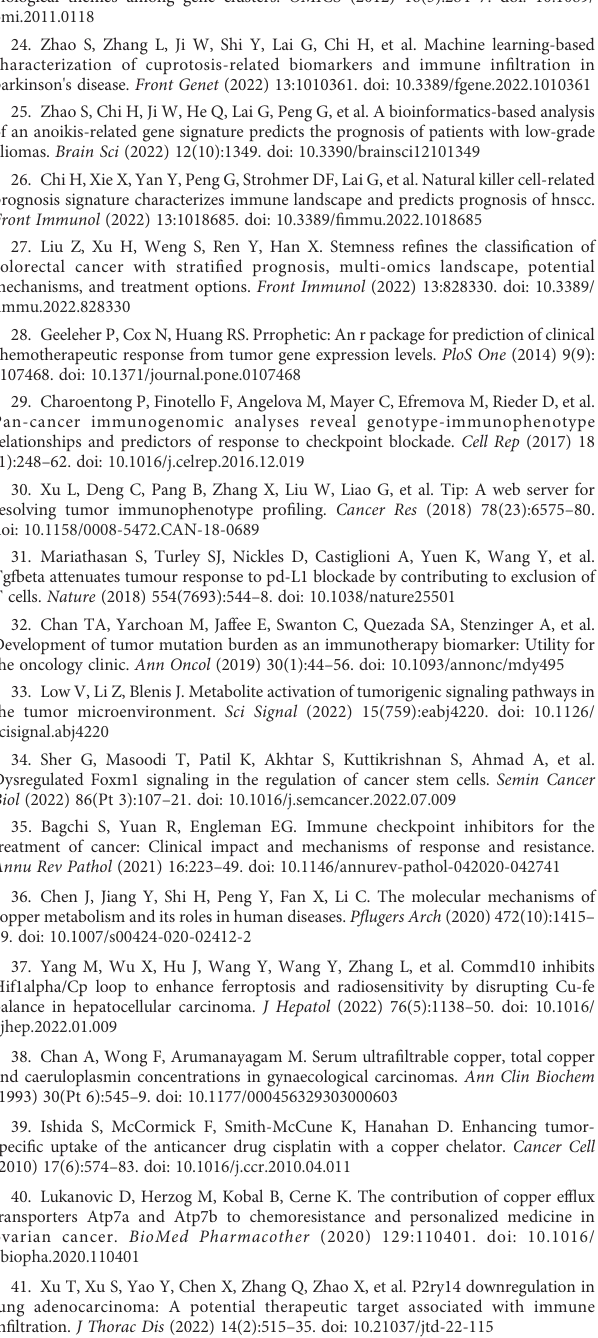
SUPPLEMENTARY TABLE 4 40 prognostically relevant DEGs screened by univariate Cox analysis. SUPPLEMENTARY TABLE 5 Detailed cohort information for the 2 CM gene clusters by the consensus clustering